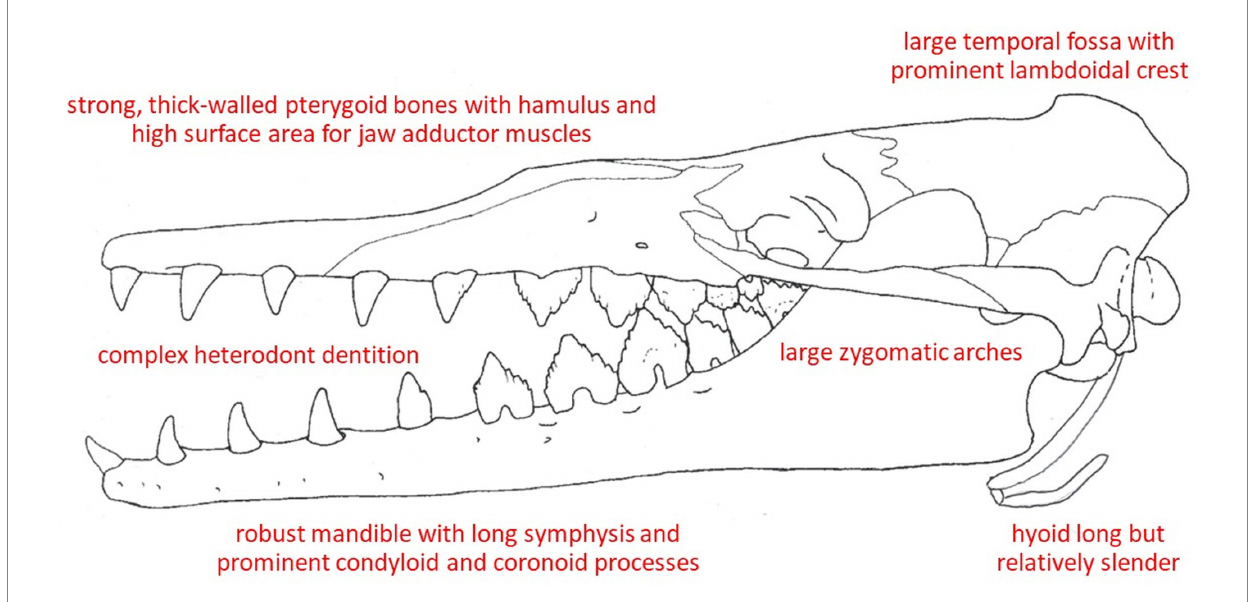
FIGURE 6 Osteological correlates of feeding in a dorudontine basilosaurid, Zygorhiza kochii , that is presumed similar to the ancestral condition of modern